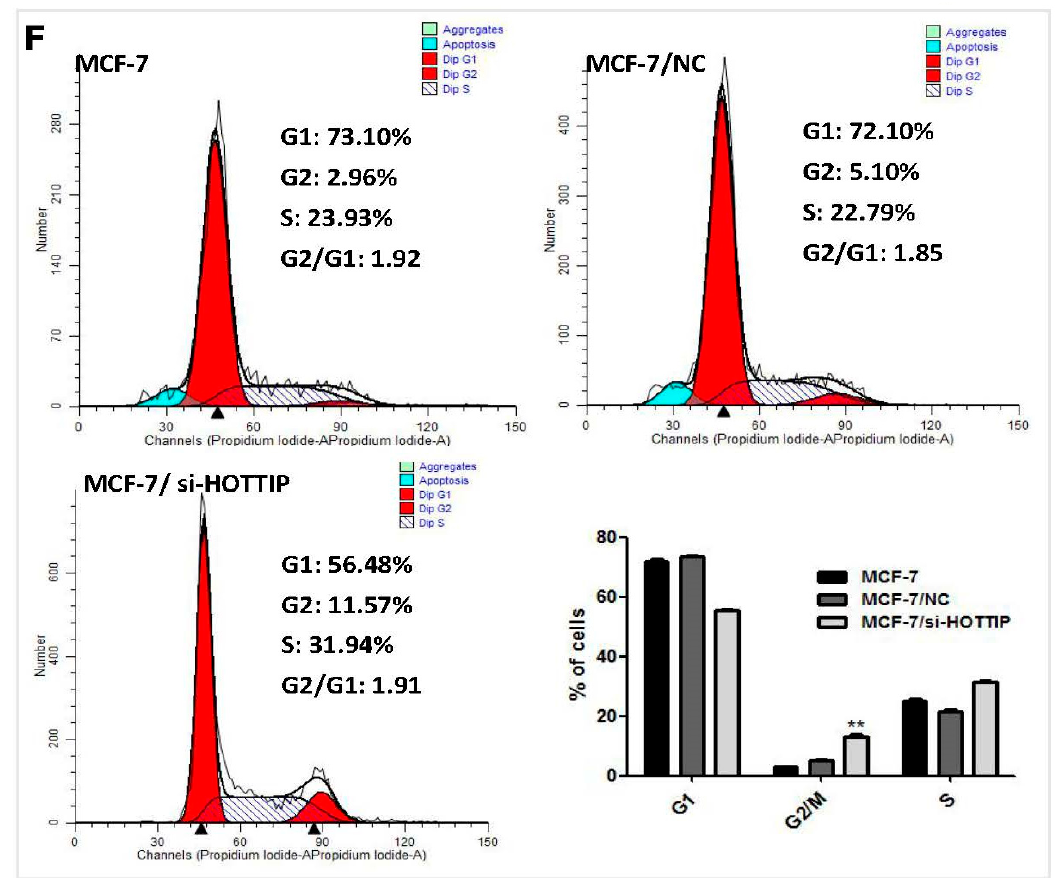
Figure 1. HOTTIP (HOXA transcript at the distal tip) may be involved in the proliferation, colony formation, and cell cycle arrest of breast cancer cells. ( A ): Expression of HOTTIP and HOXA gene clusters in MCF-7 and MCF-10A cells. ( B ): Effective RNAi sequences of HOTTIP knockdown were screened by RT-qPCR. ( C ): HOTTIP knockdown may inhibit cell proliferation of MCF-7 cells. ( D ): HOTTIP knockdown may inhibit colony formation ability of MCF-7 cells. ( E ): Quantitative results of cells colony formation with HOTTIP knockdown. ( F ): HOTTIP knockdown may lead to an increase in G2/M phrase cell amounts. NC (negative control) group stands for empty vector transfected control cells. * p < 0.05; ** p <